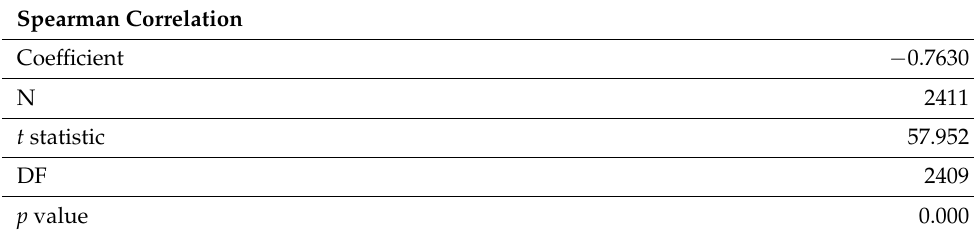
Table 2. Spearman